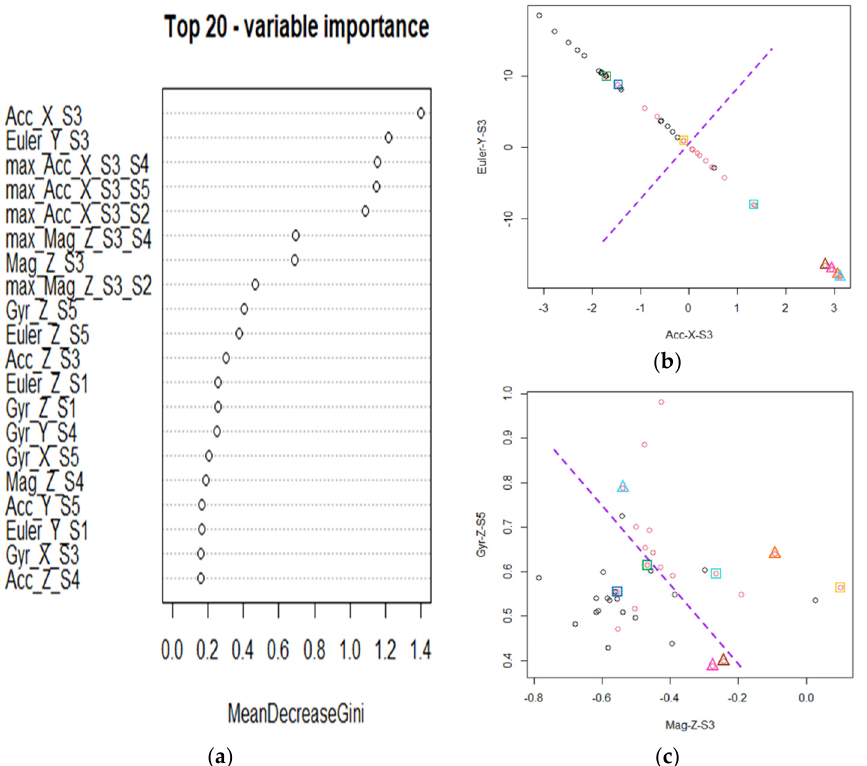
Figure 8. ( a ) The top 20 important classification variables of RF 6 , where the x-axis presents the mean decrease in Gini coefficient of each variable. ( b ) Classification diagram of the first two important variables of RF 6 , where the values in the x- and y-axis are computed from (1) using corresponding variables. ( c ) Classification diagram of the 3rd and 4th important variables excluding the 5 filtered variables designed from the original features of RF 6 , where the values in the x- and y-axis are computed from (1) using corresponding variables. In ( b , c ), the black (or red) circles represent the observations of PC (or HD).at N 6 . The red circles in color boxes or triangular represent the extremely aberrant observations detected by the filtered variables listed in Table 3 for N 6 . The dashed lines represent the classification boundaries. In addition, the boxes (or triangular) in the same color are the observations of the same